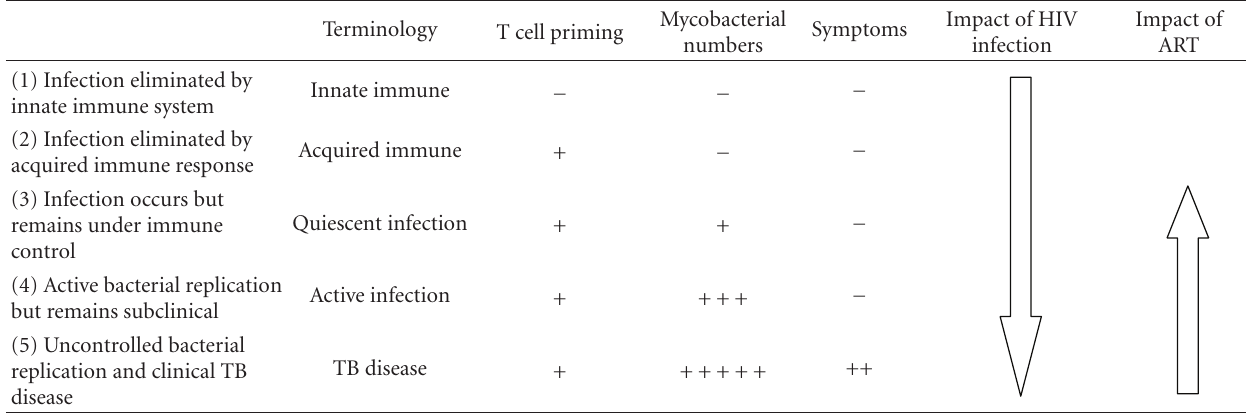
Table 2: Proposed framework of potential outcomes of the host-pathogen relationship following exposure to Mycobacterium tuberculosis infection. (adapted from [9,